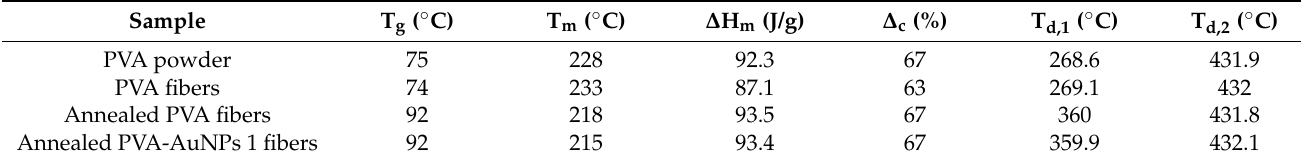
Annealed PVA-AuNPs 1